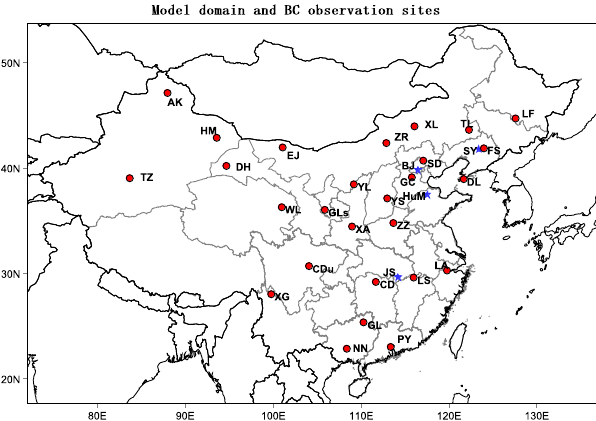
Figure 1. The GRAPES–CUACE model domain and BC observa- tion sites used in this study. Observations considered for assimi- lation are shown as red points, while observations considered for verification are shown as blue stars. Information about stations is shown in Table